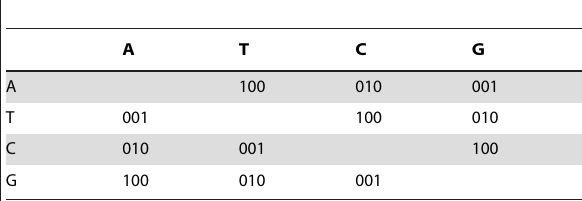
Table 1. Mutation encoding scheme (dummy